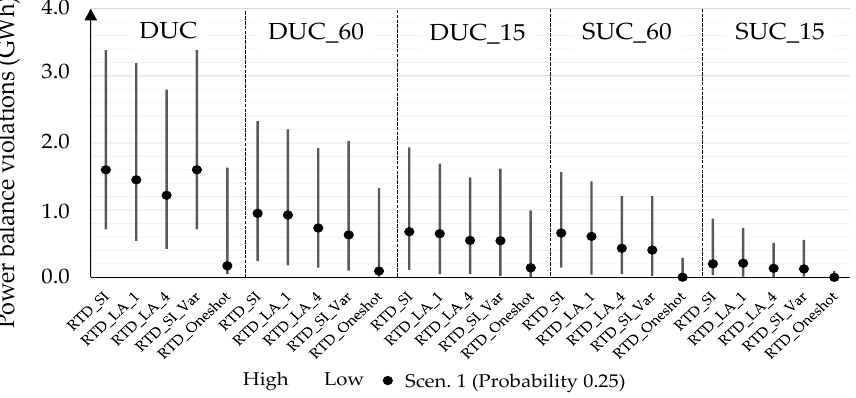
Figure 6. Daily power balance violations for all UC-RTD combinations.